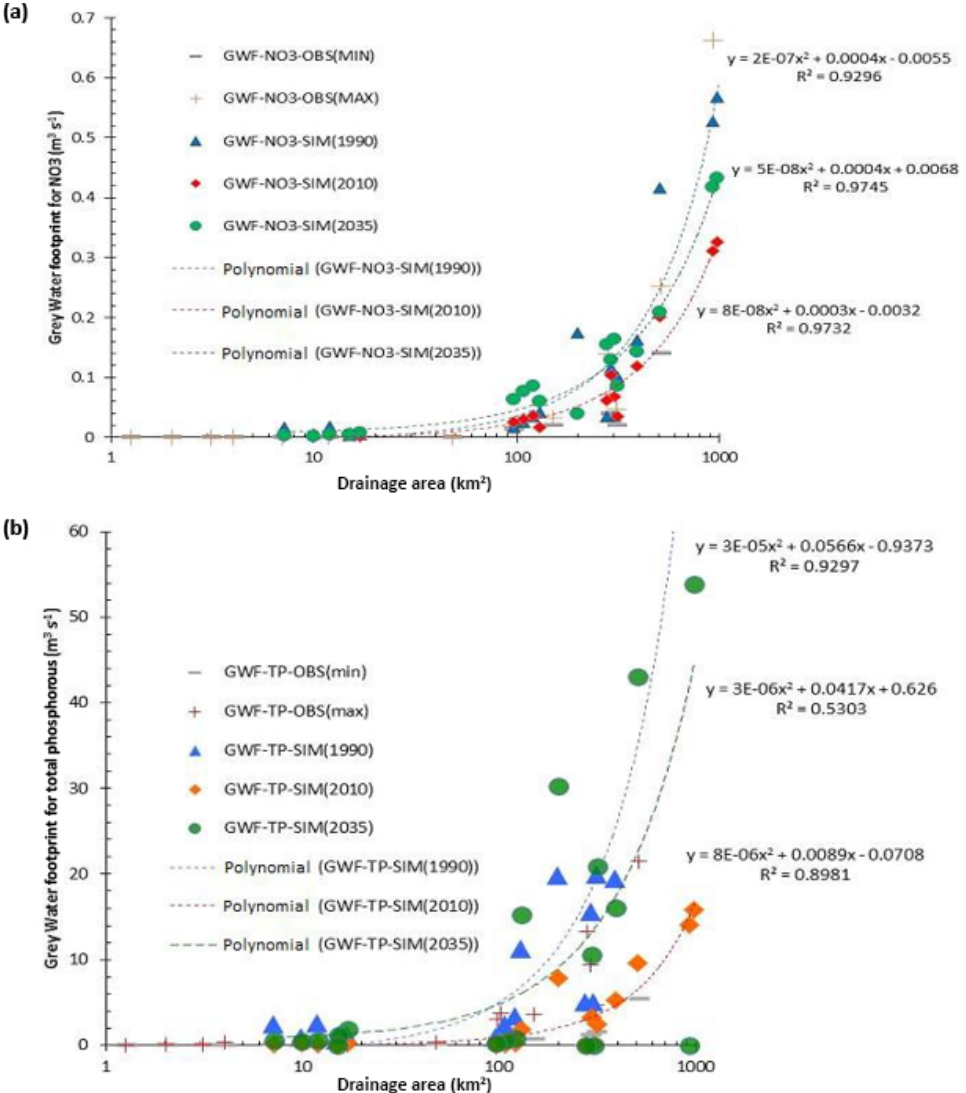
Figure 15. Relationships between grey water footprint for nitrate (a) and total phosphorous (b) according to three LULC scenarios (1990, 2010 and 2035) and size of the drainage areas of headwaters in the Cantareira water supply